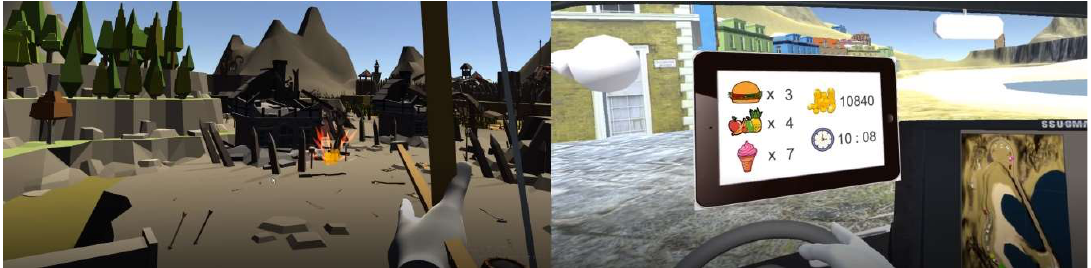
Figure 6. VR development application step—Beta Project.